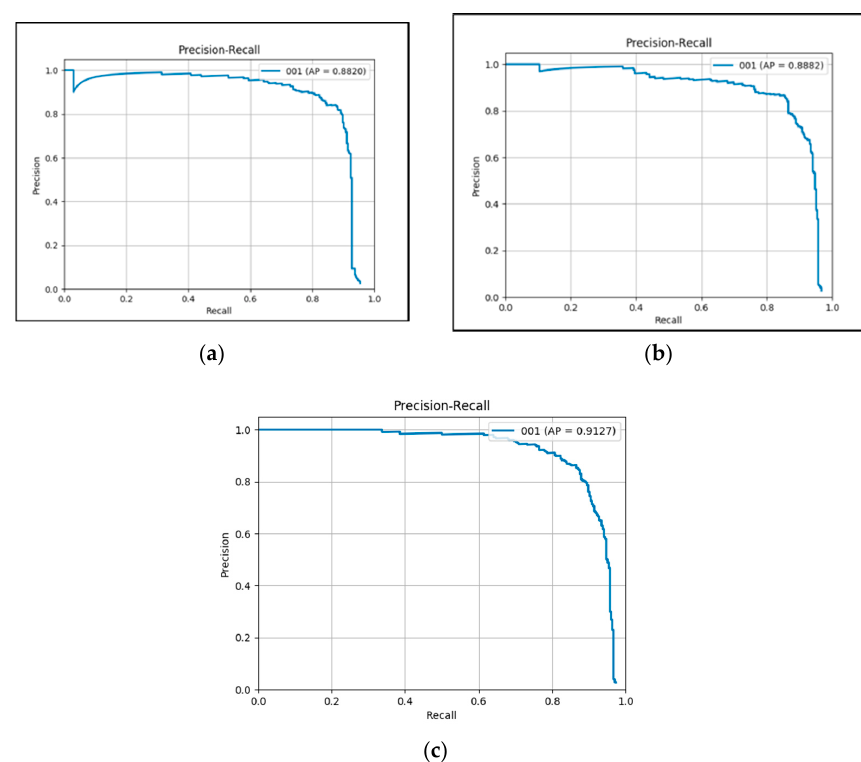
Figure 6. ( a ) P-R curve of framework1.1 ( b ) P-R curve of framework1.2 ( c ) P-R curve of framework 1.3. Table 2. R, P, mAP, F1-score and test time on VEDAI dataset.